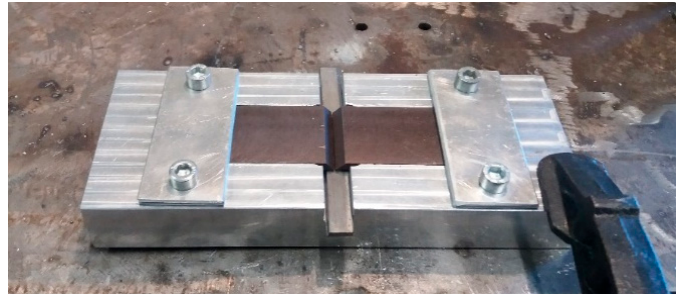
Figure 2. Jig designed and manufactured for welding Sibodur ® 450 samples in this work.